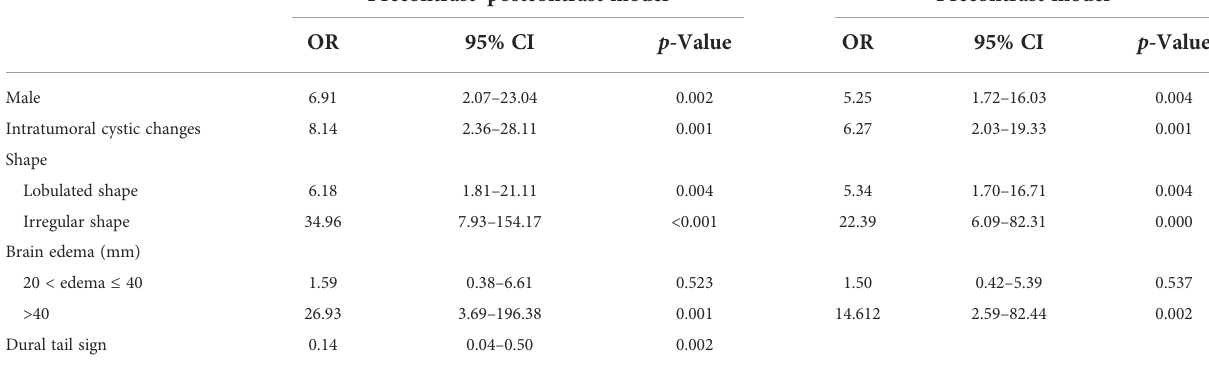
TABLE 4 The multivariable logistic regression analysis of two models. Precontrast – postcontrast